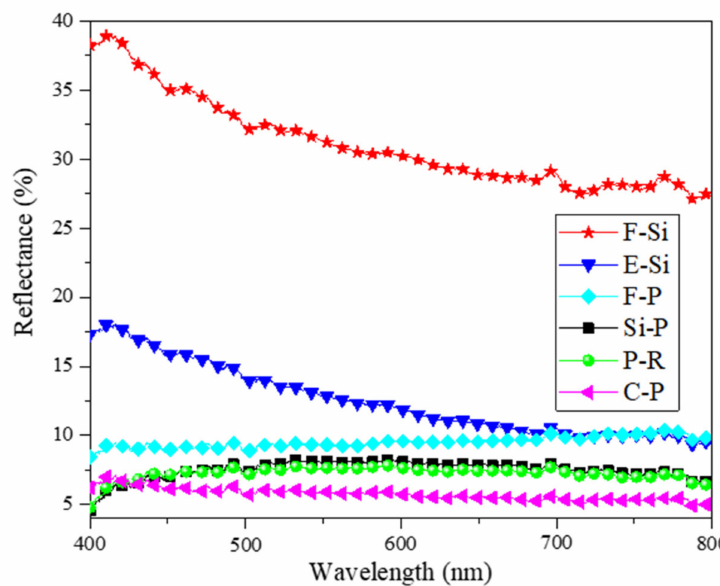
Figure 4. Reflectance spectra for each